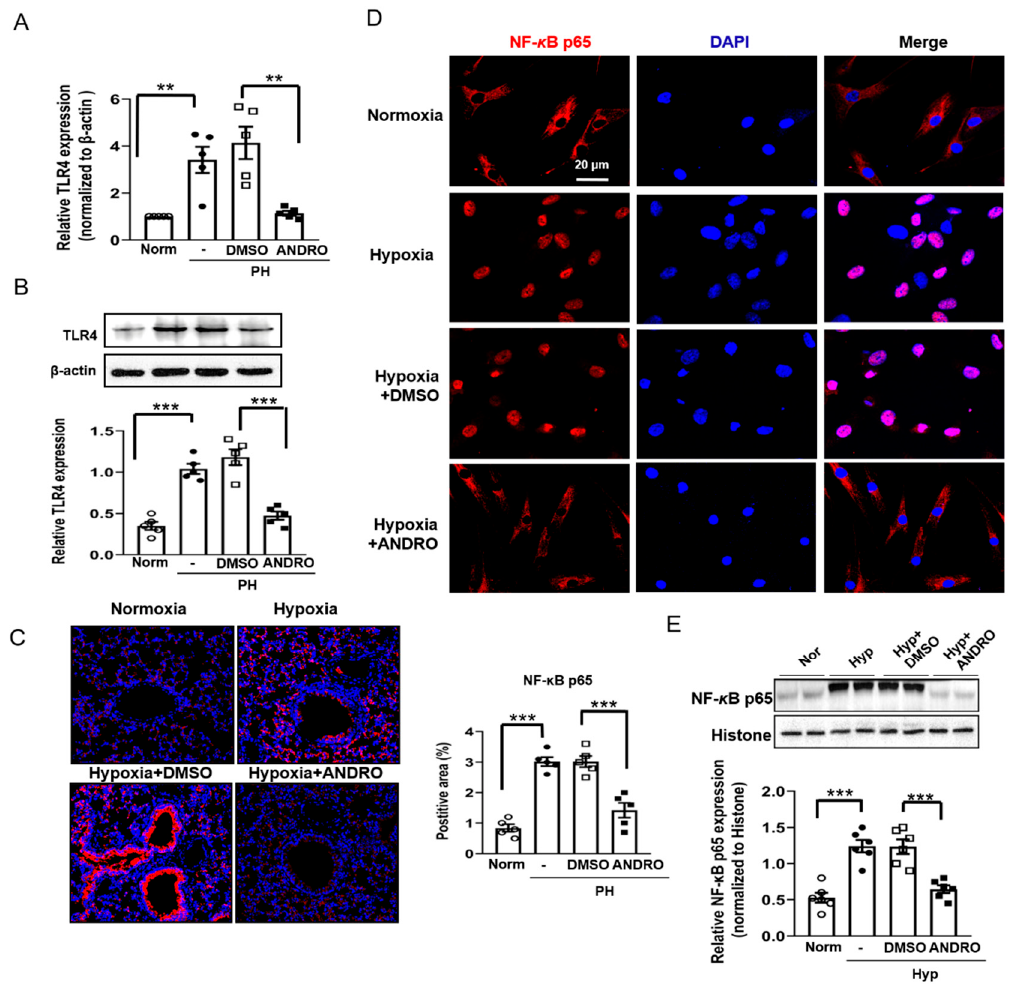
Figure 5. ANDRO suppressed the activation of NF- κ B in human PH-PASMCs or PAs of PH mice. ( A , B ) qPCR ( A ) and Western blotting ( B ) analysis showing that ANDRO (30 μ M, 24 h) suppressed the mRNA and protein expression of TLR4. ( C ) Representative immunohistochemical staining and group data showing that ANDRO inhibited the expression of phosphorylated-NF- κ B p65 (Ser276) in the lung tissues of hypoxia-induced PH mice. Scale bars are 50 μ m. ( D , E ) immunofluorescence ( D ) and Western blotting ( E ) analysis showing that ANDRO (30 μ M, 24 h) reversed hypoxia-induced translocation of p65 to nuclei. Data represent mean ± SEM. n = 5, ** p < 0.01, *** p < 0.001.